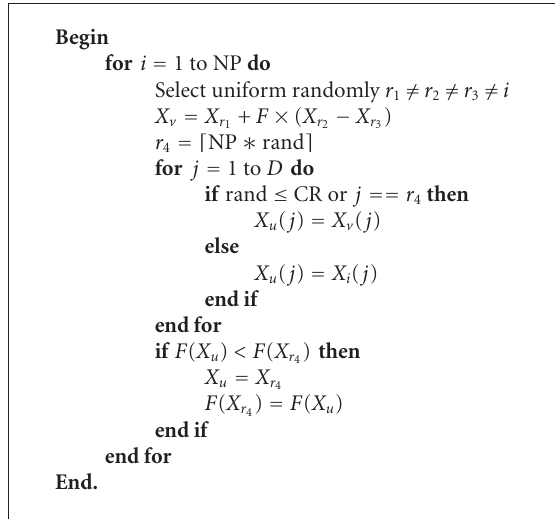
Algorithm 3: Algorithm of selecting cuckoo for